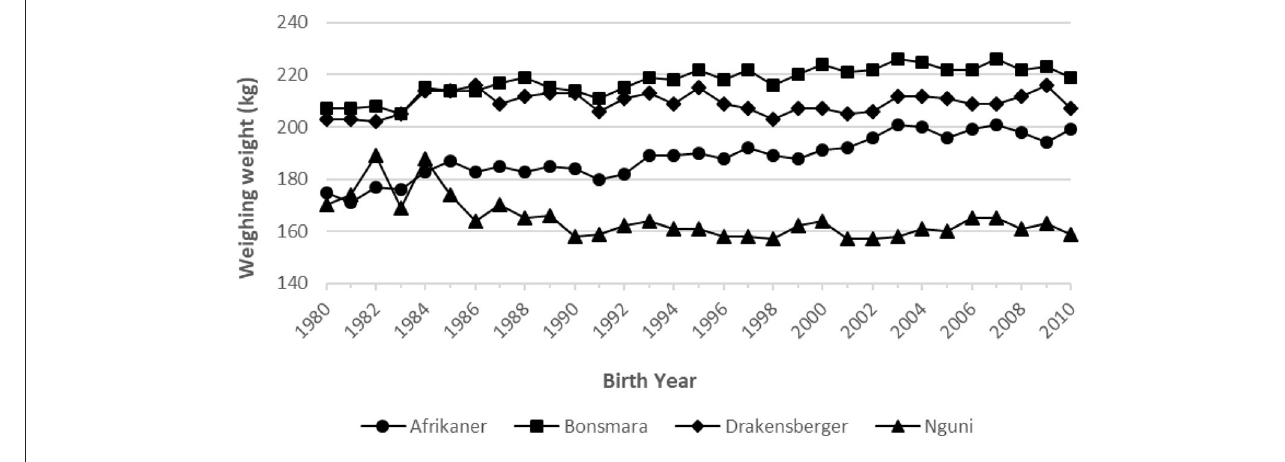
FIGURE 2 | Phenotypic trend for weaning weight for the four breeds.